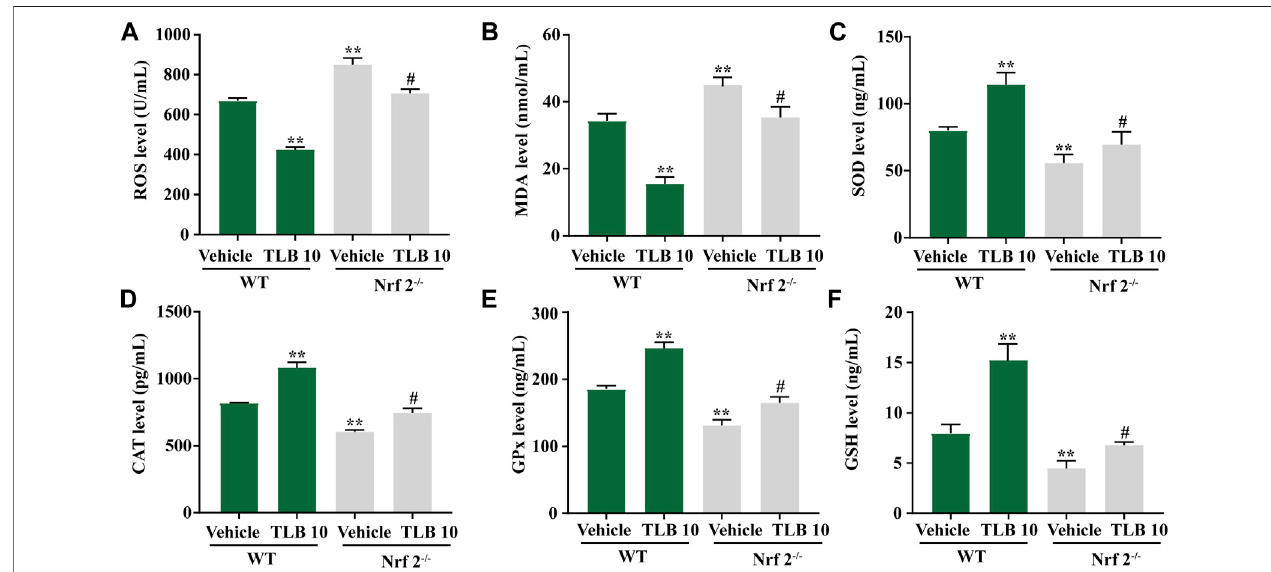
FIGURE 8 | Schematic illustration of molecular mechanisms for the protective effect of TLB on EEIF in mice. TLB exerts a potent protective effect on EEIF in mice through mediating the Nrf2/ARE/ferroptosis signaling pathway, thereby suppressing oxidative stress.